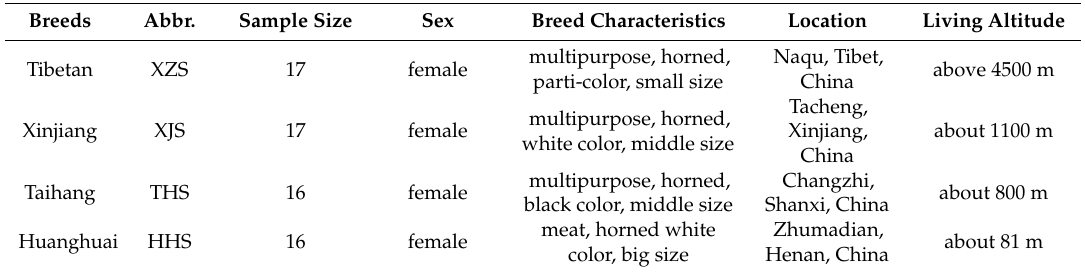
Table 1. Information of the Chinese goat populations in this